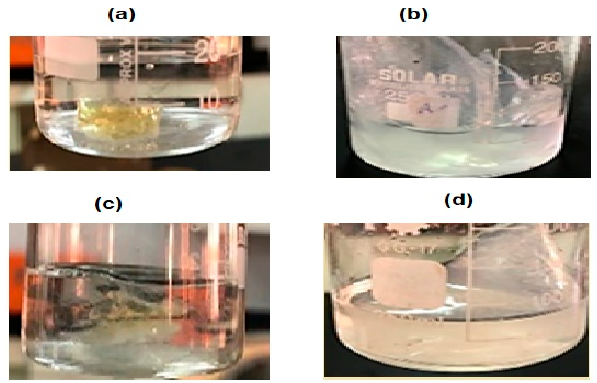
Figure 4. Photos of the swelled ( a ) M1, ( b ) M4, ( c ) AM1 and ( d ) AM4 terpolymers gels.